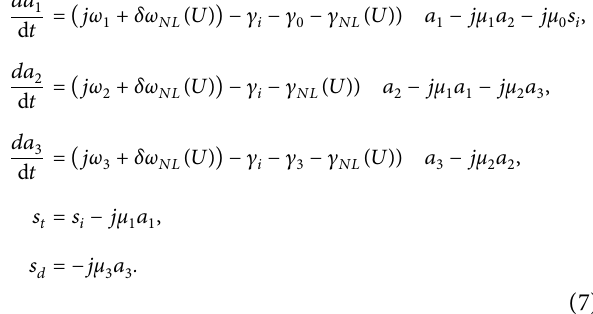
Figure 1: Schematic of the 3D model of the designed flter. Te color code for diferent layers is the same as in Figure